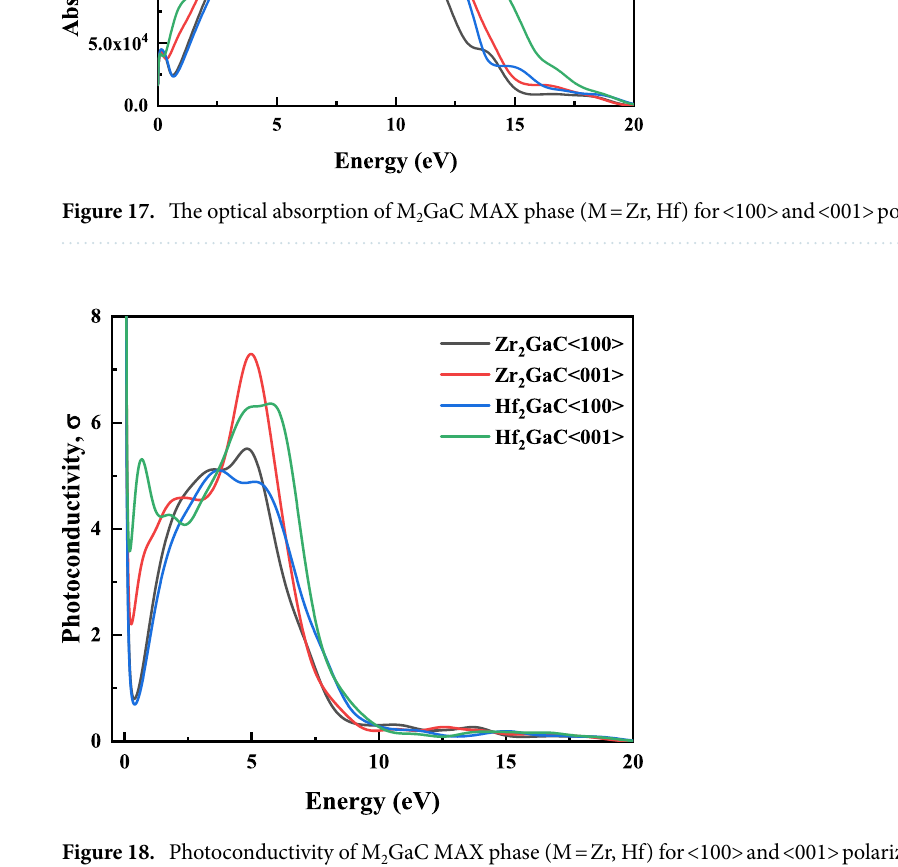
Figure 18. Photoconductivity of M 2 GaC MAX phase (M = Zr, Hf) for <100> and <001>